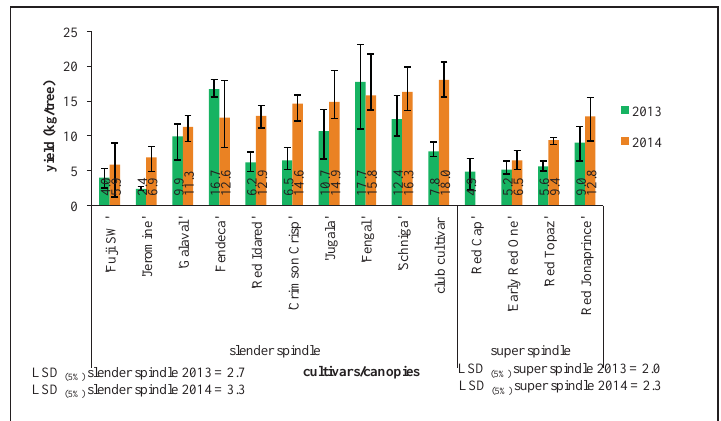
Figure 2 : Yields (kg/tree) of 14 apple cultivars (Nyírbátor, 2013 and 2014).